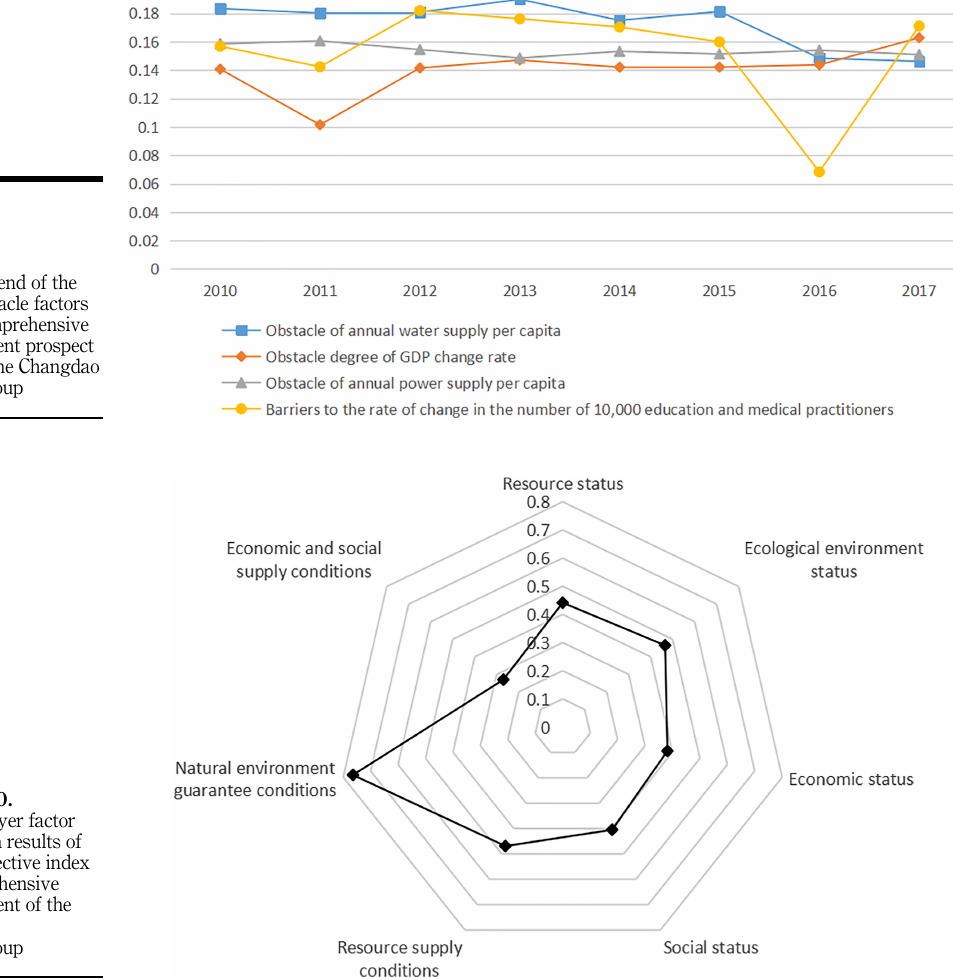
Figure 10. Criteria layer factor evaluation results of the prospective index of comprehensive development of the Changdao Island